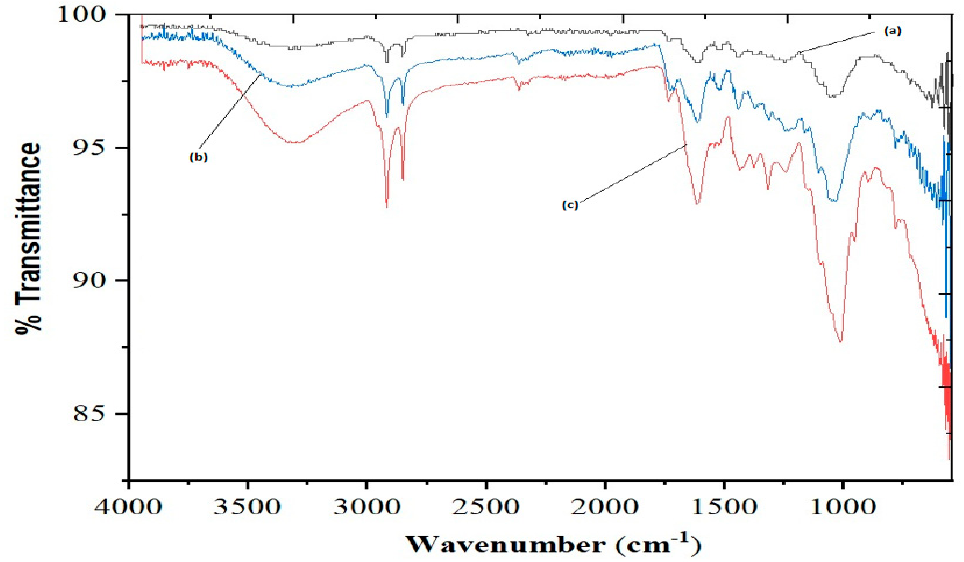
Figure 1. Infrared spectra of ( a ) Moringa peregrina biomass; ( b ) Moringa peregrina biomass treated with NaOH; ( c ) Moringa peregrina biomass treated with citric acid.